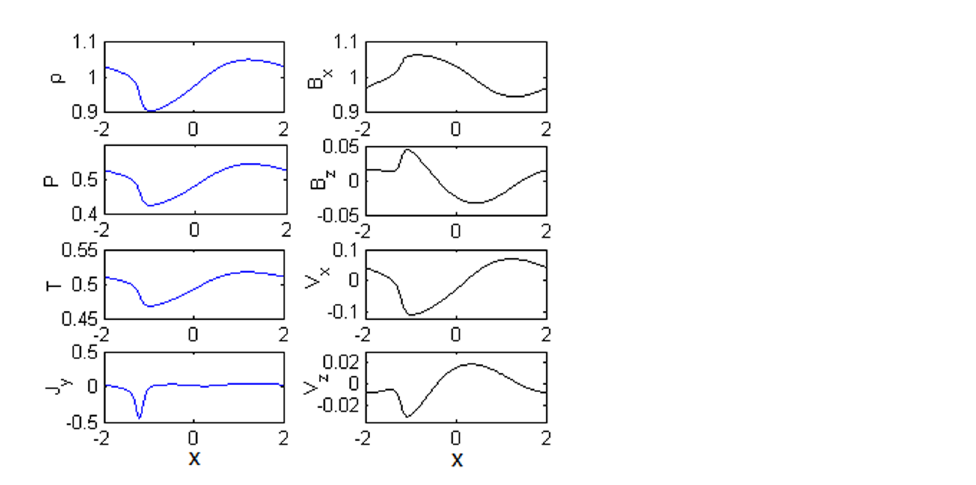
Figure 3. The profiles of the plasma density ( ρ ), the plasma pressure (P), the plasma temperature (T), the current density (J y ), the magnetic field (B x and B z ), and plasma velocity (v x and v z ) along the x axis at z = 1 at t = 51.